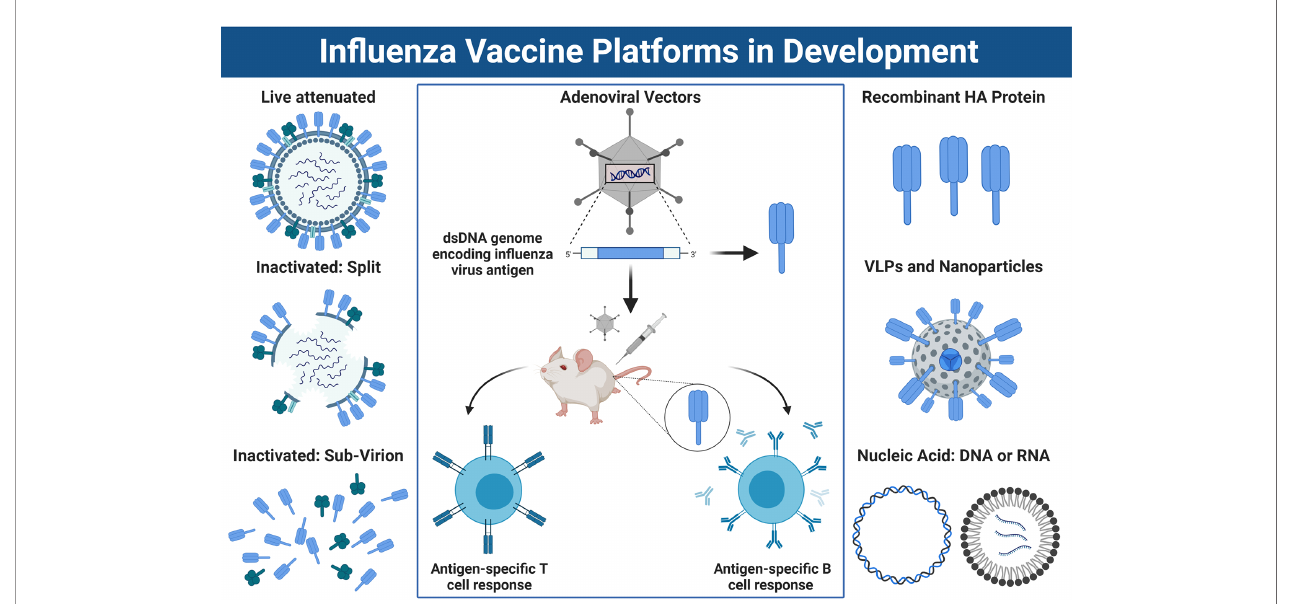
FIGURE 4 | Approaches for In fl uenza Vaccine Development. Left panel : A schematic overview of conventional in fl uenza virus vaccine platforms, including the live attenuated vaccine (LAIV), the split virion inactivated in fl uenza vaccine (IIV) or IIV sub-virion vaccine, which has HA>NA content. Right panel: Newer vaccines being developed include recombinant HA protein, virus-like-particles or nucleic acid-based vaccines such as DNA or mRNA platforms. Center panel: Schematic overview of how non-replicating adenoviral (Ad) vectored vaccines work. DNA sequence encoding an in fl uenza virus antigen is inserted into the dsDNA genome of the Ad vector under the control of a powerful promoter to drive expression. Once immunized, the DNA sequence coding for the in fl uenza antigen is transcribed into mRNA and translated into protein which is expressed inside the host cells at the site of injection and/or within draining lymph nodes. This results in a robust CD8 + T cell response, as well as humoral immune responses directed towards the encoded transgene antigen. Note: the trimeric stalk of HA, or tetrameric stalk of NA are not shown in the diagram and icons are not to scale. Figure created with © BioRender -